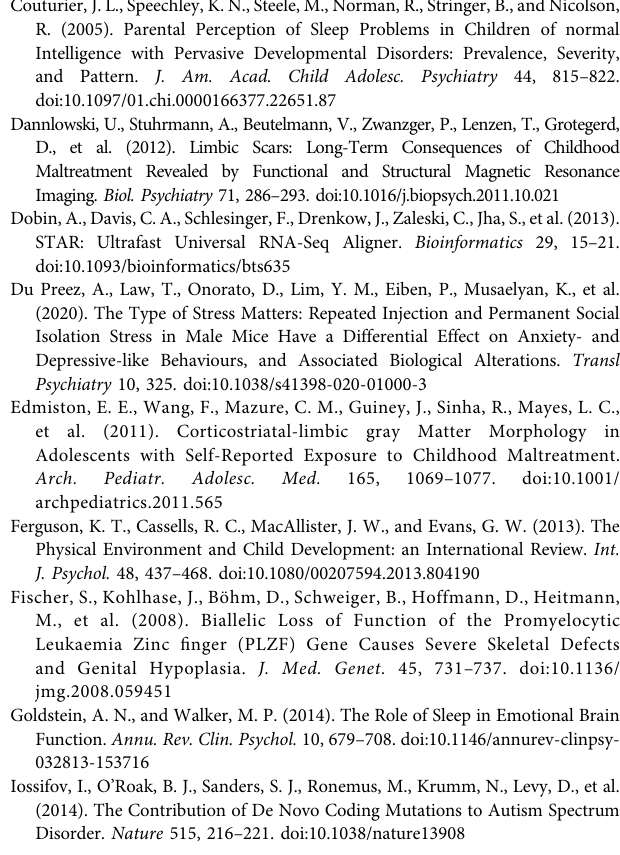
Supplementary Figure S1 | An impairment of sociality in ELS mice. Supplementary Table S1 | The list of DEGs in ELS mice. Supplementary Table S2 | The list of ToppGene information of